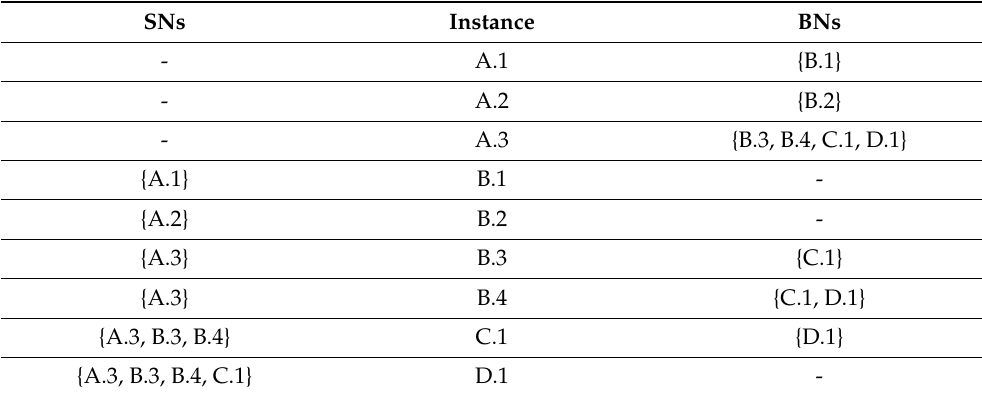
Table 4. Neighborhood table of instances.